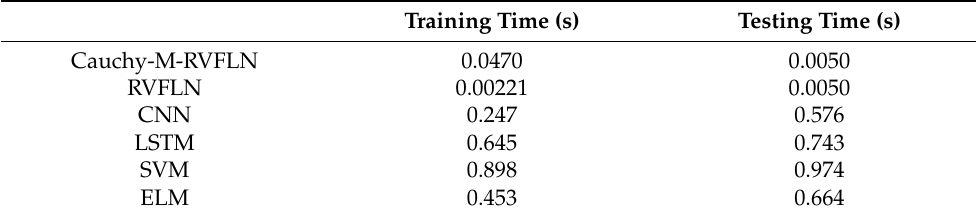
Table 5. Comparison of train/test